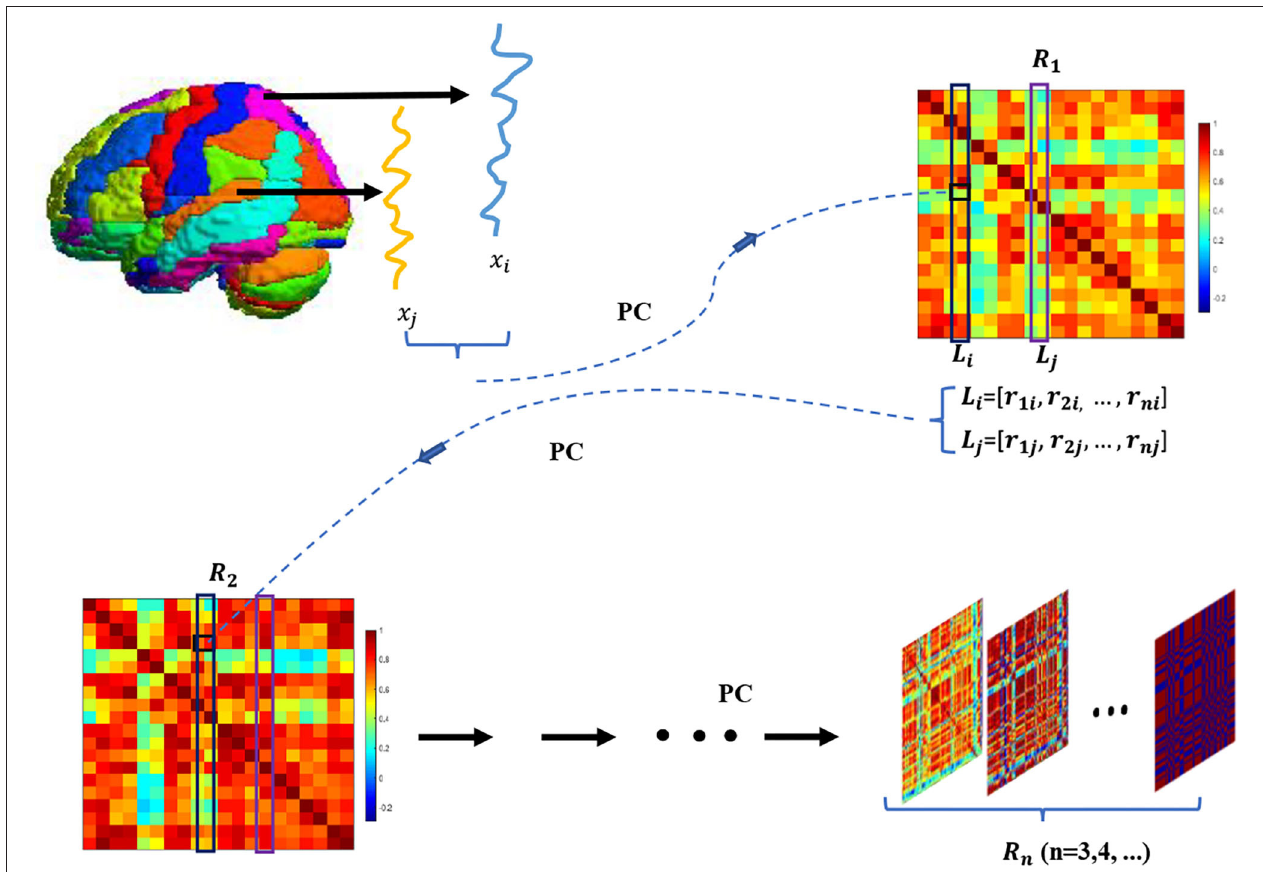
FIGURE 2 | The pipeline of building R n . R 1 is first obtained via computing PC coefficient of the BOLD signals associated with different ROIs. Then, R 1 is seen as the new data matrix to calculate R 2 , where the feature vector L i is considered as a new “signal” that indicates the correlation between the ith ROI and other ROIs. By continuously conducting the above operation, we calculate R n ( n = 2,3, ···